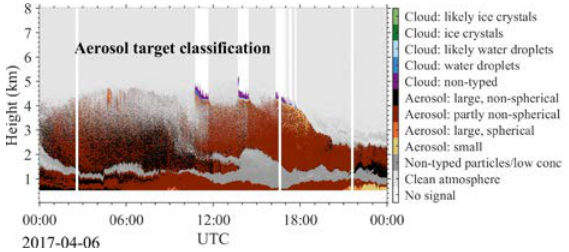
Figure 7. Aerosol target classifications on 6 April 2017 for Limassol,